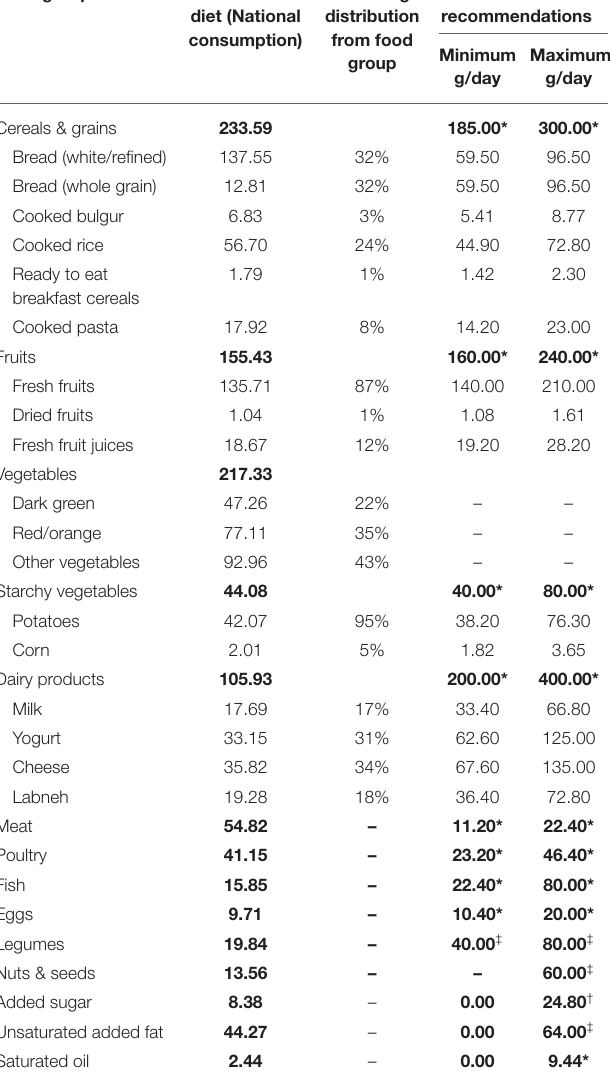
TABLE 2 | Food group/item minimum and maximum constraints. Food group